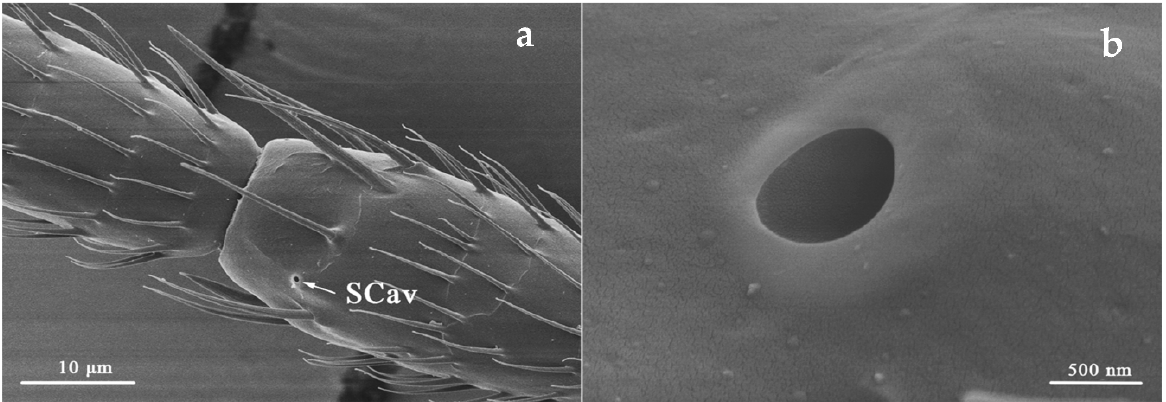
Figure 7. Sensilla cavity (SCav) is located on flagellum III ( a ) and a SCav was shown in higher resolution ( b ) in S. kaszabi .